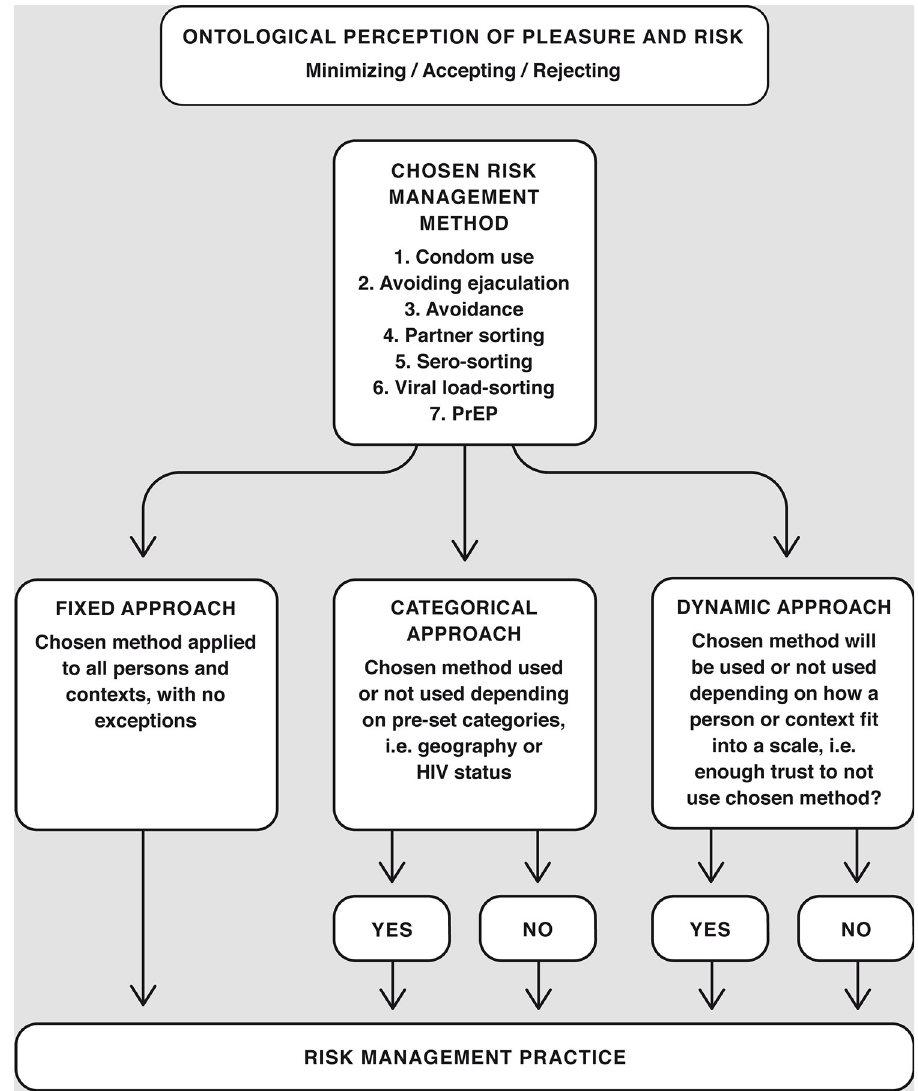
Fig 1. Conceptualization model: The decision process for each risk management method